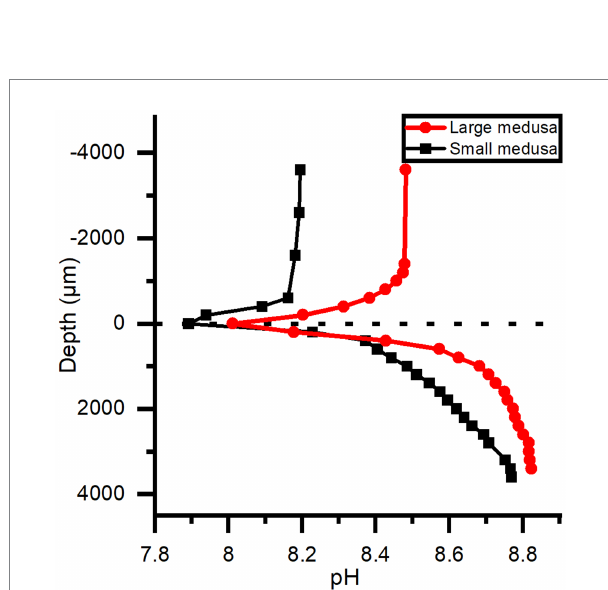
FIGURE 9 pH depth profiles measured in the bells of a small and large medusae, where 0 μ m is tissue surface and 4,000 μ m is the deepest inside the tissue. Both individuals were kept under an incident photon irradiance (400–700 nm) of 580 μ mol photons m − 2 s − 1 light for > 15 min and then in darkness for ~ 15 min before profiles were